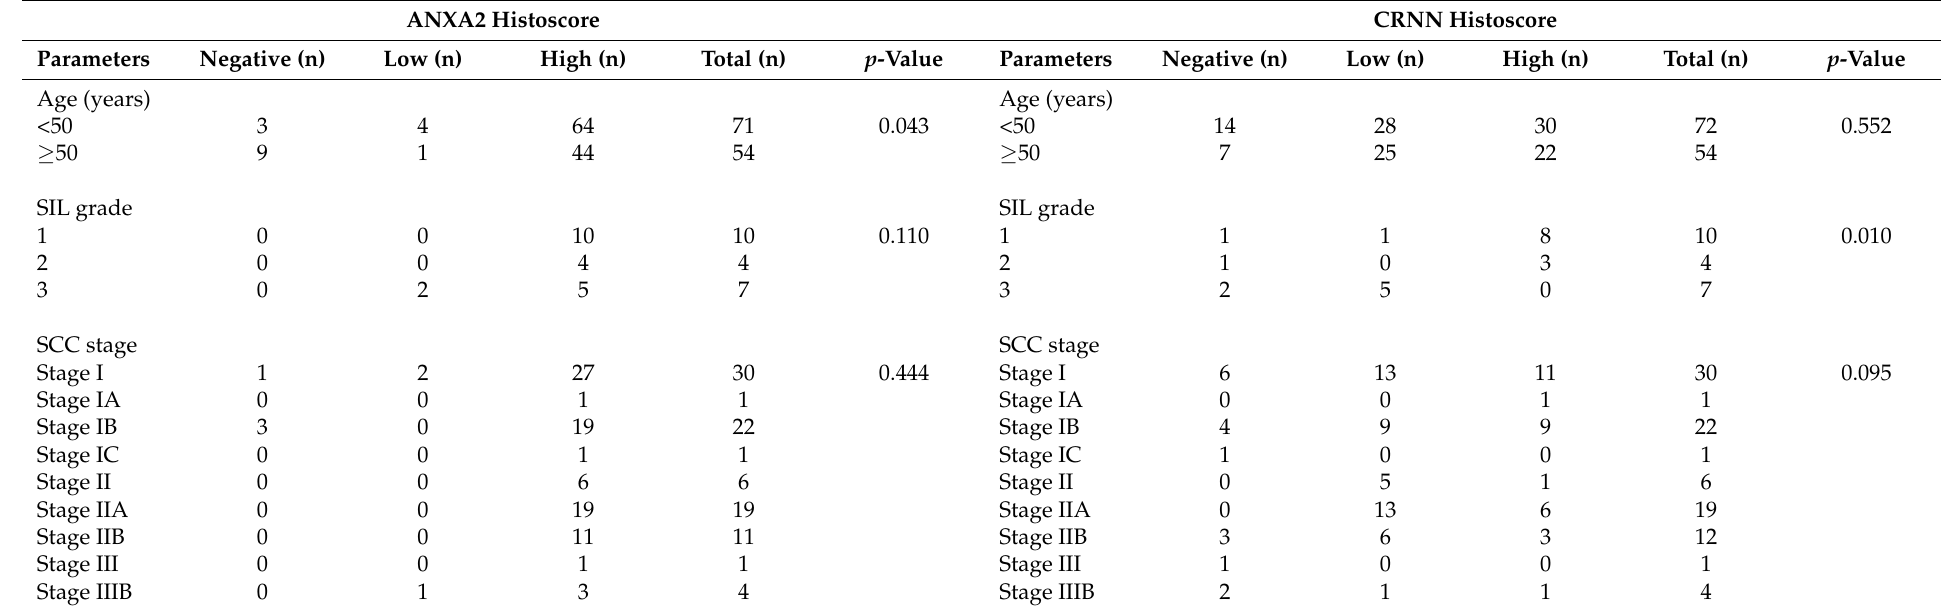
Table 5. Comparison of ANXA2 and CRNN histoscores between the histological